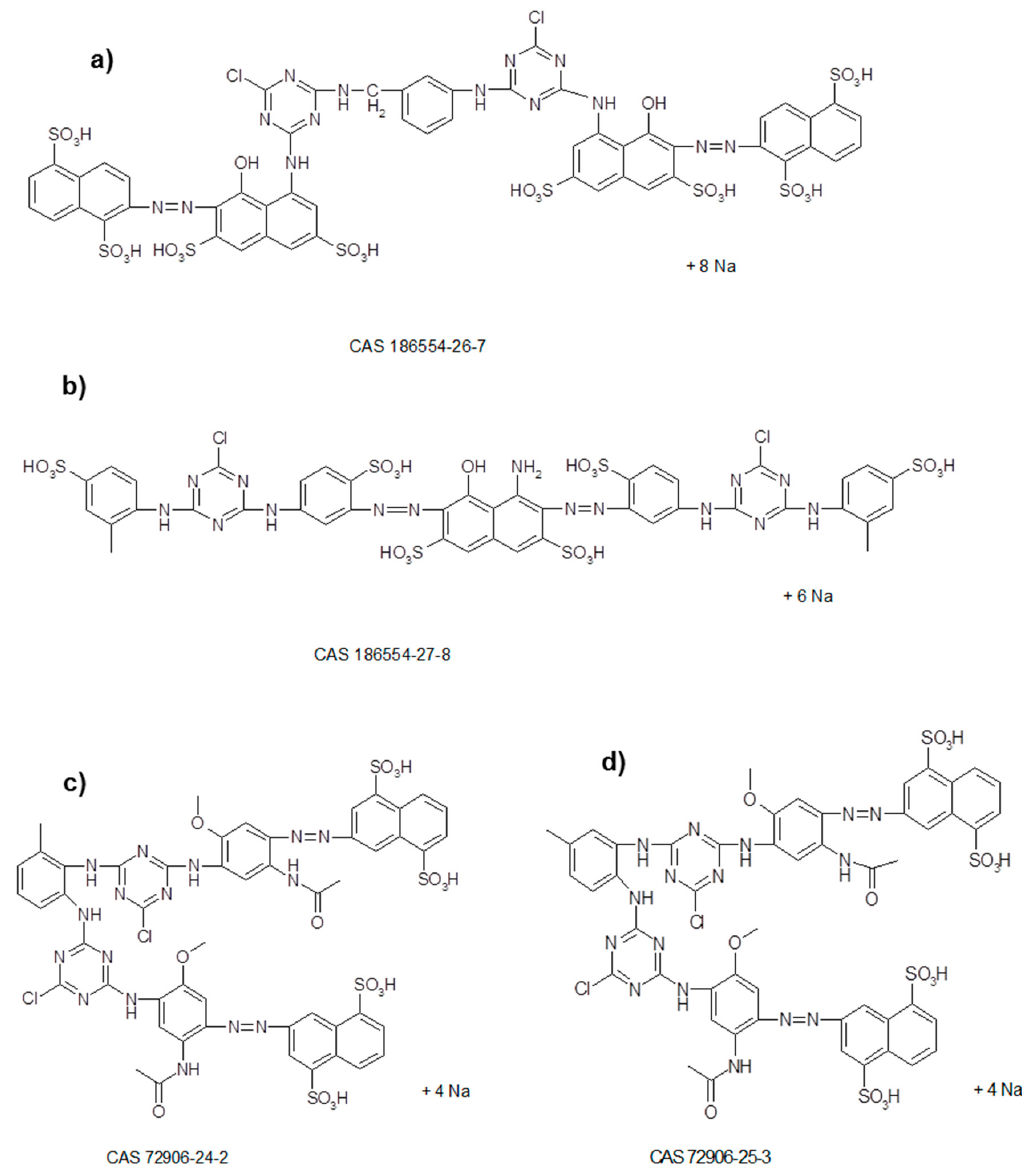
Figure 1. Chemical structure and CAS number of the dyes: PC ( a ); PN (mixture of a , b ); PY (mixture of c , d ).